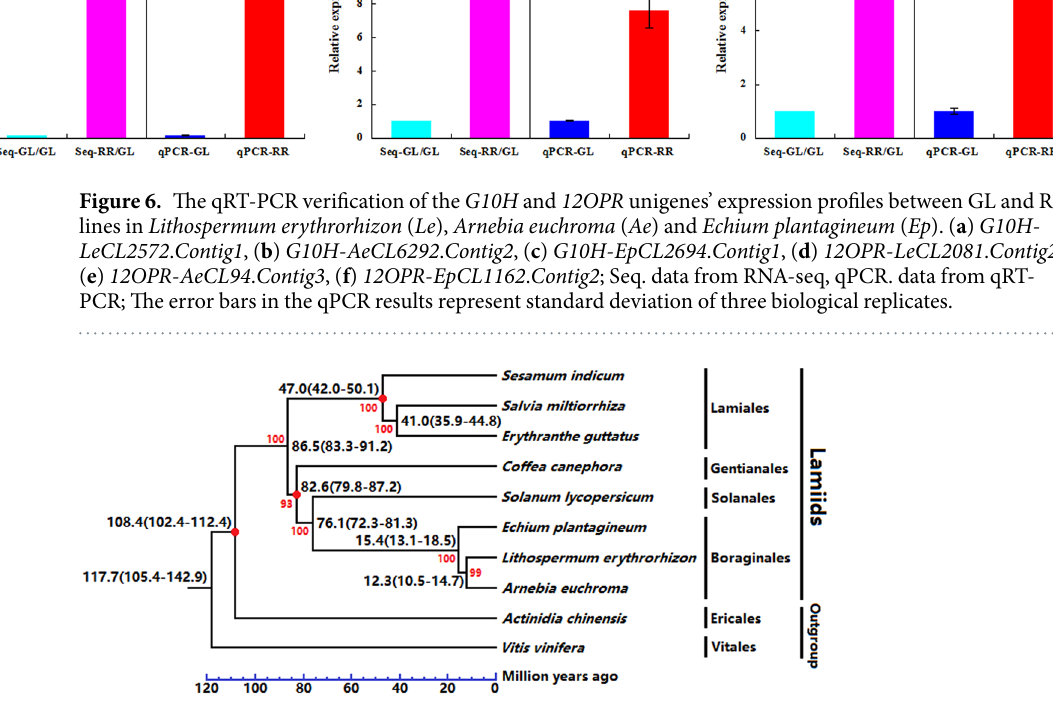
Figure 7. The phylogenetic model and divergence of Lamiids. (Black numbers) divergence times and their 95% confidence intervals, (Red numbers) maximum likelihood bootstrap support (MLBS), (Red nodes) divergence calibration